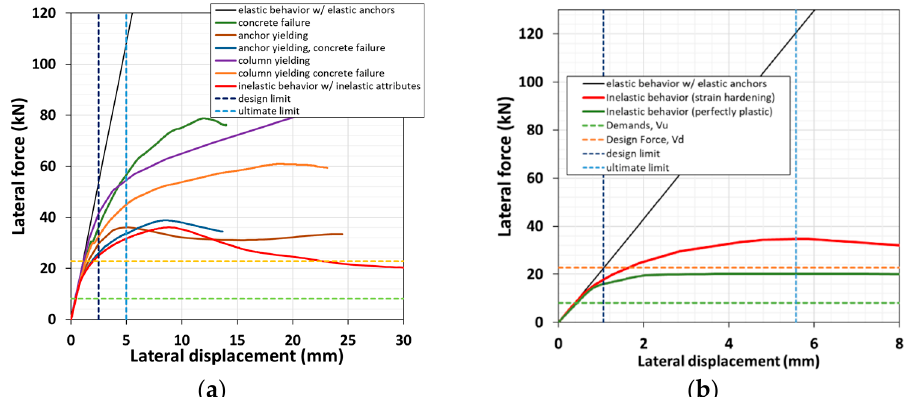
Figure 8. Pushover simulations. ( a ) Lateral force vs. lateral displacement under different failure scenarios. ( b ) Zoomed-in curves of the anchor yielding scenarios shown in (a).